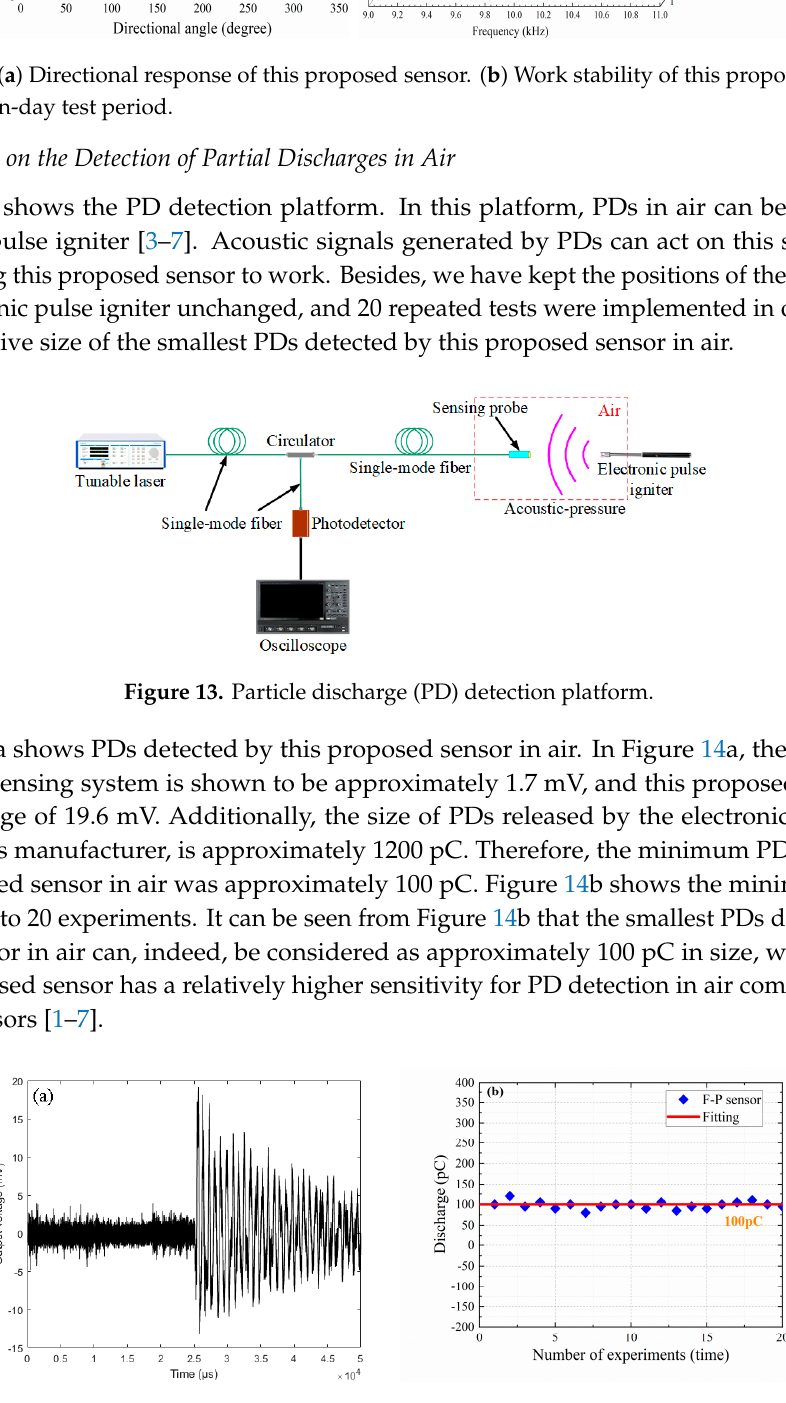
Figure 14. ( a ) PDs detected by this proposed sensor in air. ( b ) Minimum PD sizes corresponding to 20 experiments.